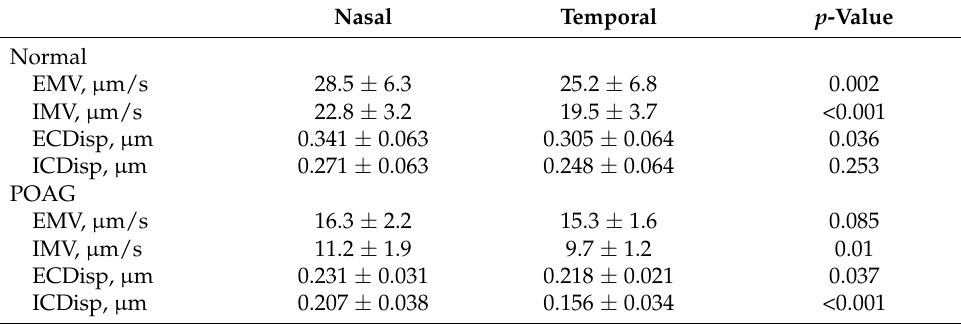
Table 3. The pulsatile TM motion in normal and POAG eyes.